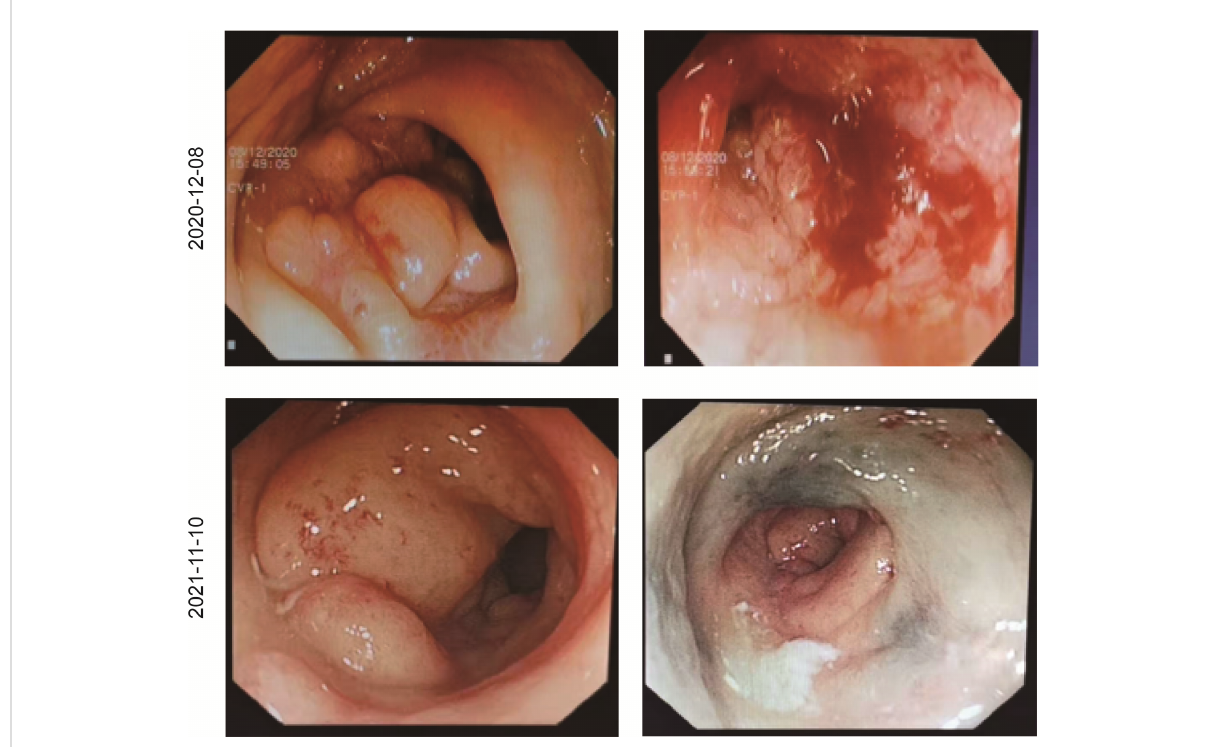
FIGURE 3 Coloscopy revealed the shrinking of the tumor following a series of treatments.